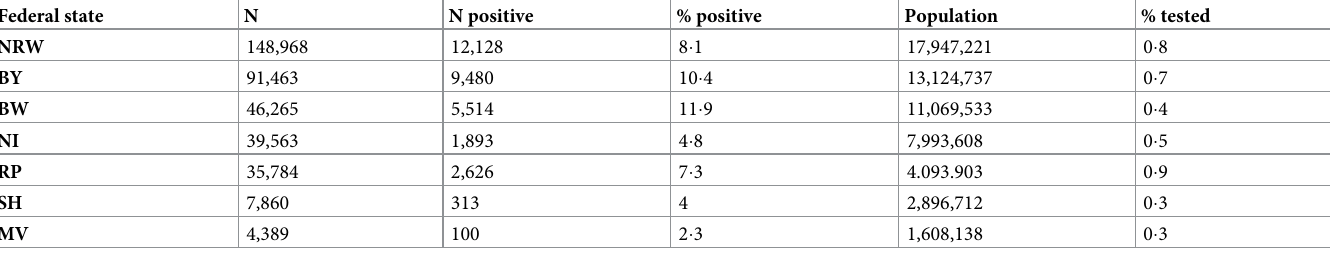
Table 4. Number of SARS-CoV-2-PCR tests (cumulative) broken down by federal state. Data status until 23.04.2020 (source RKI). Federal